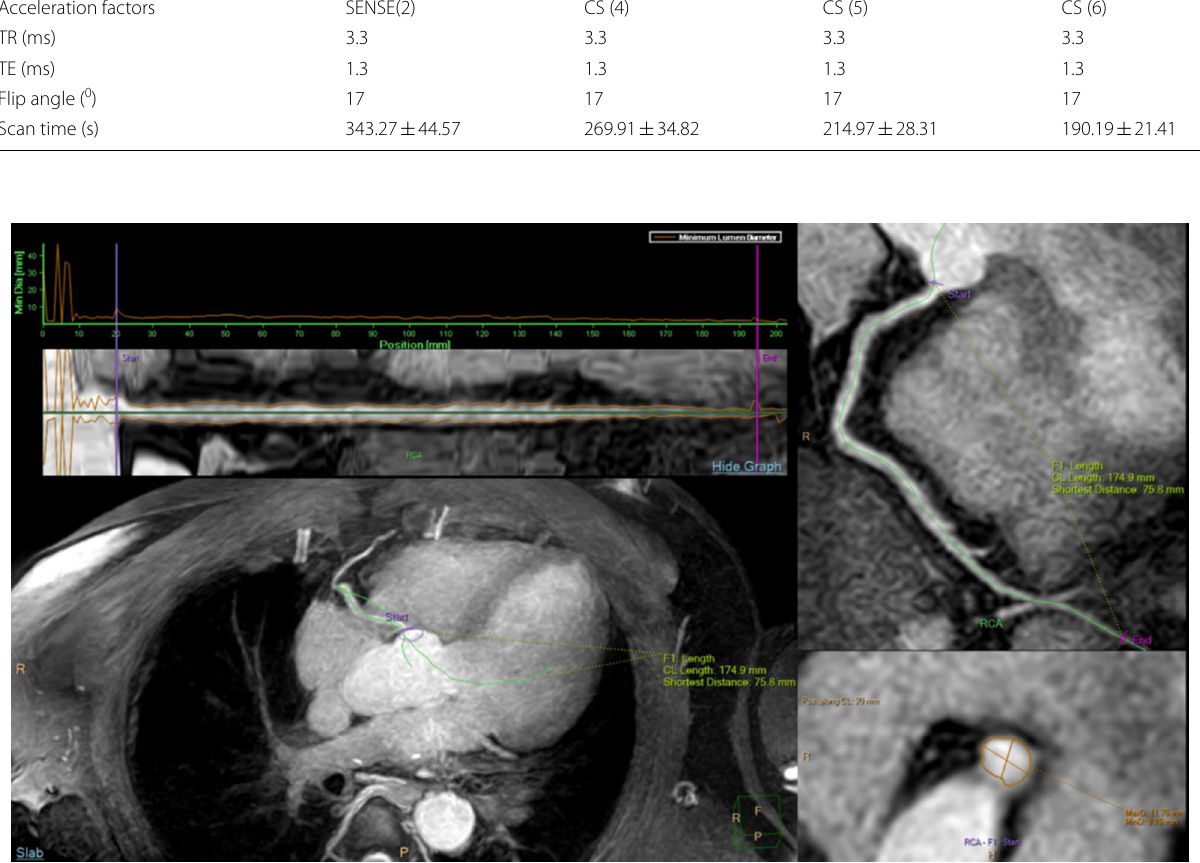
Fig. 2 Sample coronary artery CPR and visible length measurement using IntelliSpace Portal workstation. CPR, curved planar